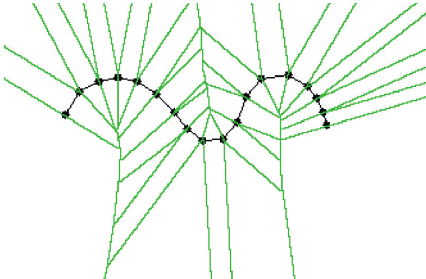
Figure 2: Voronoi diagram of a polyline of 18 points in the